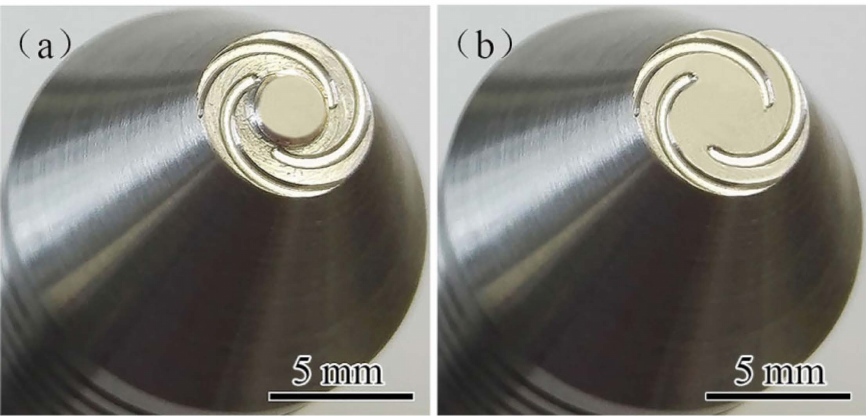
Figure 1. Profiles of friction stir welding (FSW) tools: ( a ) pin tool and ( b ) pinless tool.